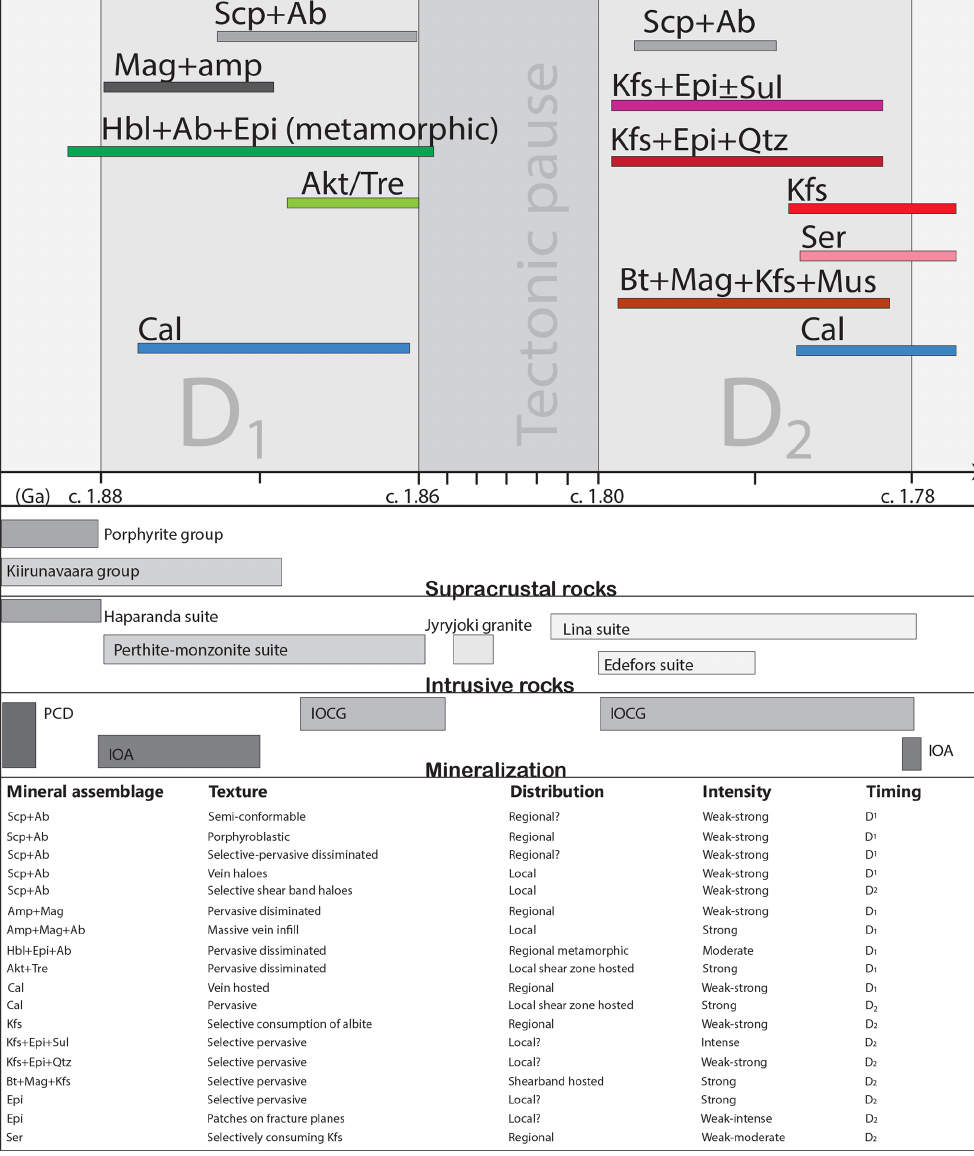
Figure 19. Summary of mineral alteration associations in the WSB and their inferred timings relative deformation. For comparison, the timing of supracrustal/intrusive rocks as well as mineralization in northern Norrbotten is included. Question mark indicates probable